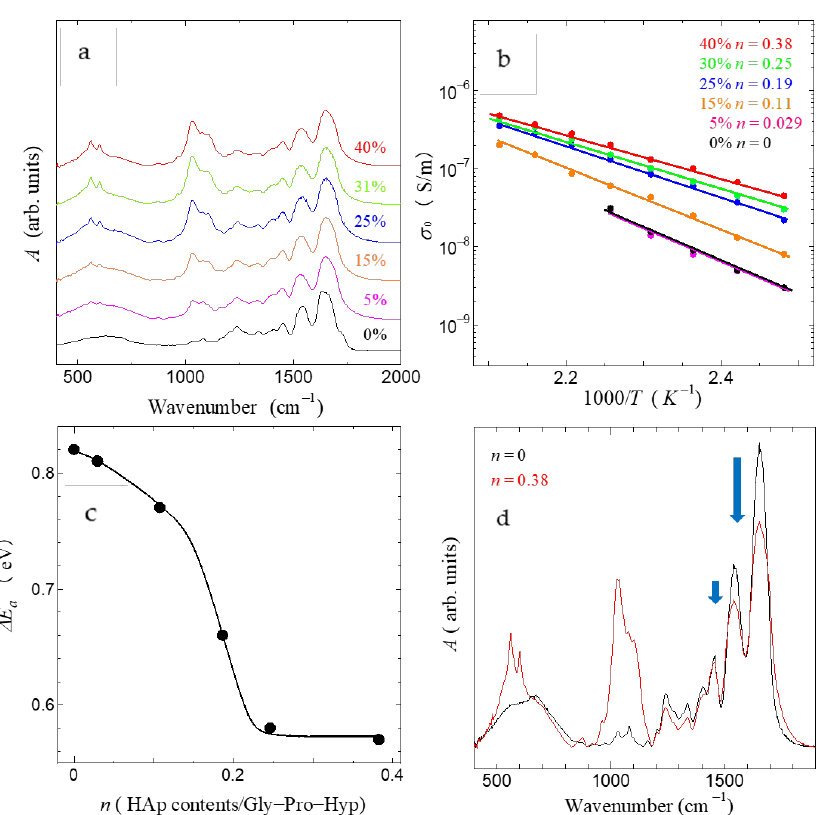
Figure 9. Proton conduction properties of HAp-collagen composite films with different HAp contents. ( a ) FT-IR spectra of HAp-collagen composite for each HAp weight ratio, ( b ) the relationship between proton conductivity and temperature for the HAp-collagen composite films at different concentrations, ( c ) the relationship between Δ Ea and HAp content n , ( d ) FT-IR spectra of collagen film and the HAp-collagen composite film of HAp weight ratio 40%.